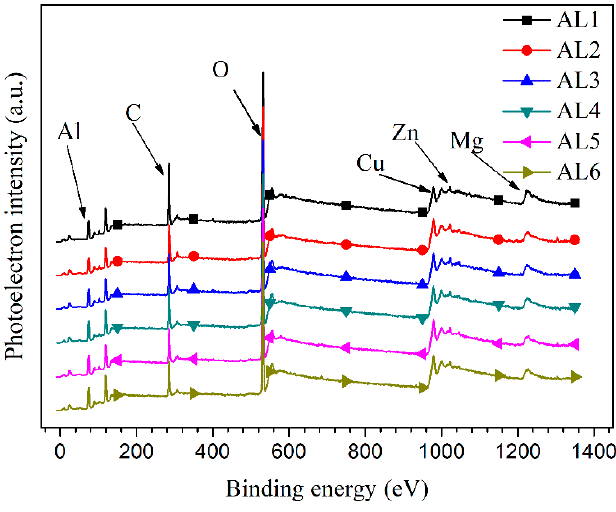
Figure 11. Survey X-ray photoelectron spectroscopy (XPS) spectra of the surface of sintered 7075 alloys.